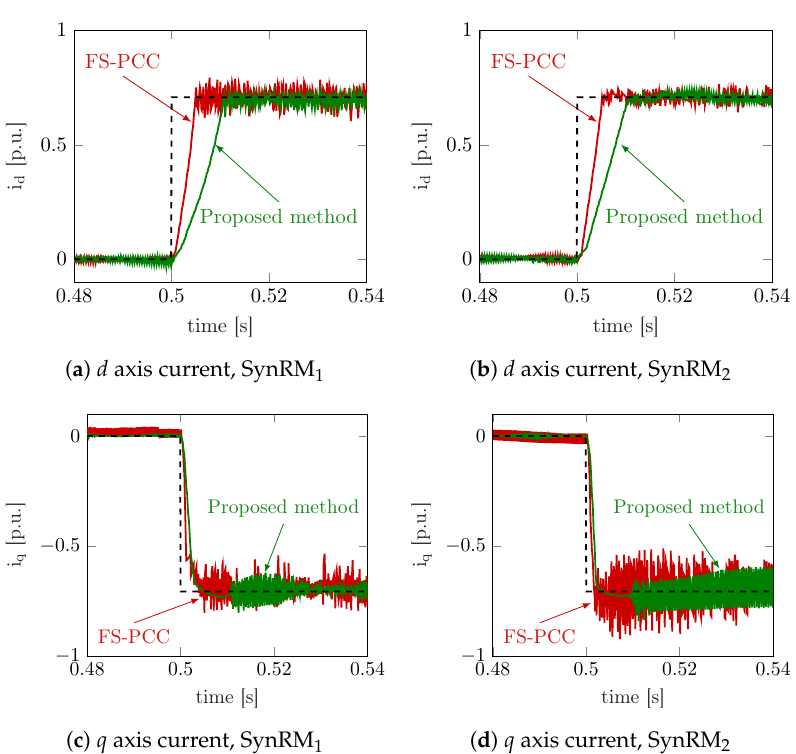
Figure 7. Current controllers performances to rated current step reference variations at 30% ω n .